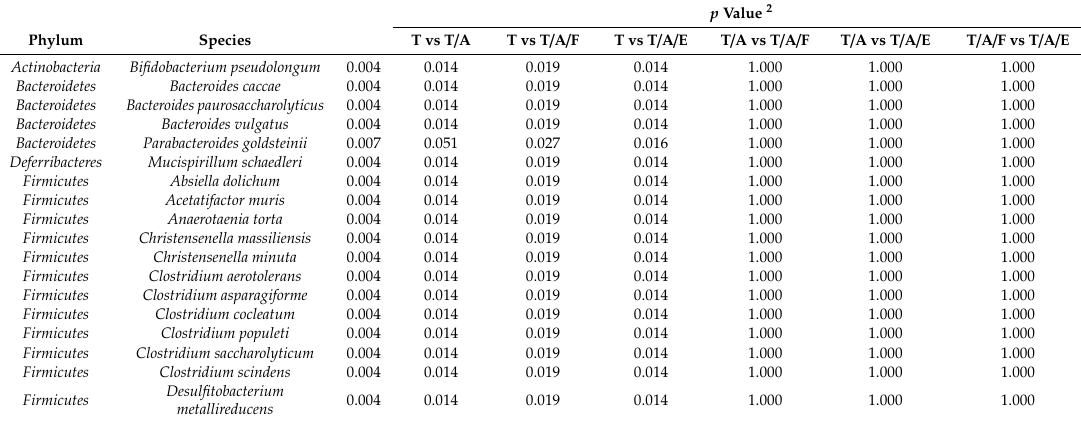
Table 2. Bacterial species with significantly varied abundance between BALB / c groups based on treatment 1